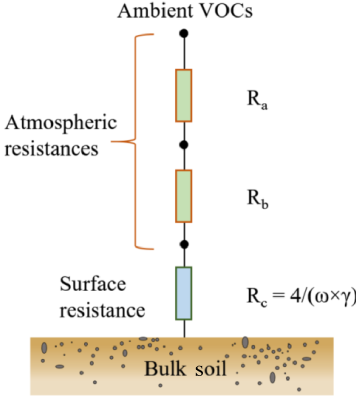
Figure 3. Schematic of the resistance model for VOC species dry deposition on soil. R a : aerodynamic resistance; R b : quasi-laminar layer resistance; R c : soil surface